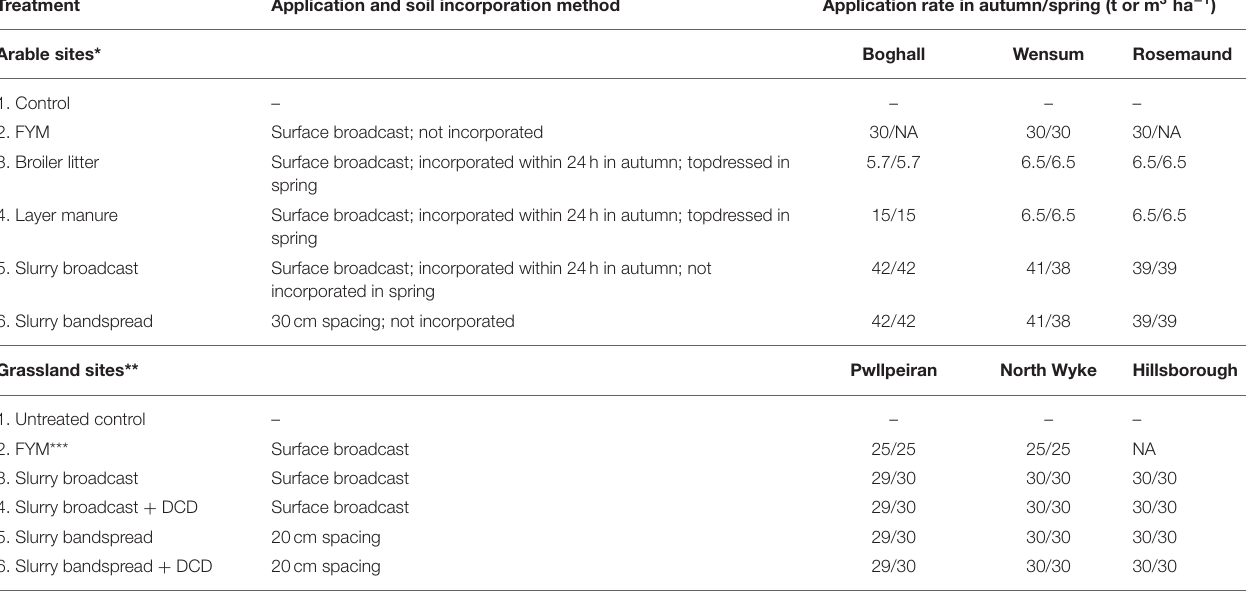
TABLE 2 | Manure treatments and application